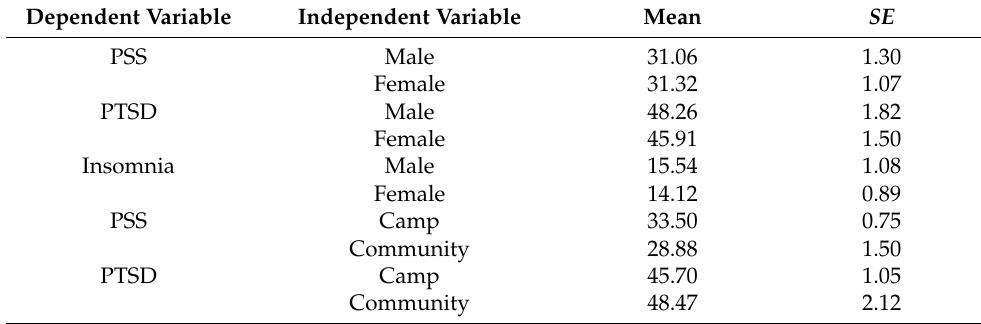
Table 2. Descriptive statistics showing mean scores across gender and place of